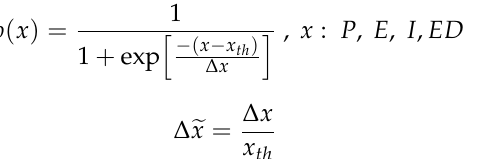
where the x represents the evaluated laser parameter such as peak power, P ; pulse energy, E ; and peak-power intensity (peak power per unit area), I ; and pulse energy density (pulse energy per unit area), ED . The solid red line shows the fitting curve given by (1) in Figure 3b,c,e,f. According to the numerical fitting, the P th corresponding to 50% breakdown probability was 0.972 MW. In other words, the I th was determined to be 0.63 TW/cm 2 . In addition, the ∆ P and ∆ (cid:101) P was found to be 44 kW and 0.045,